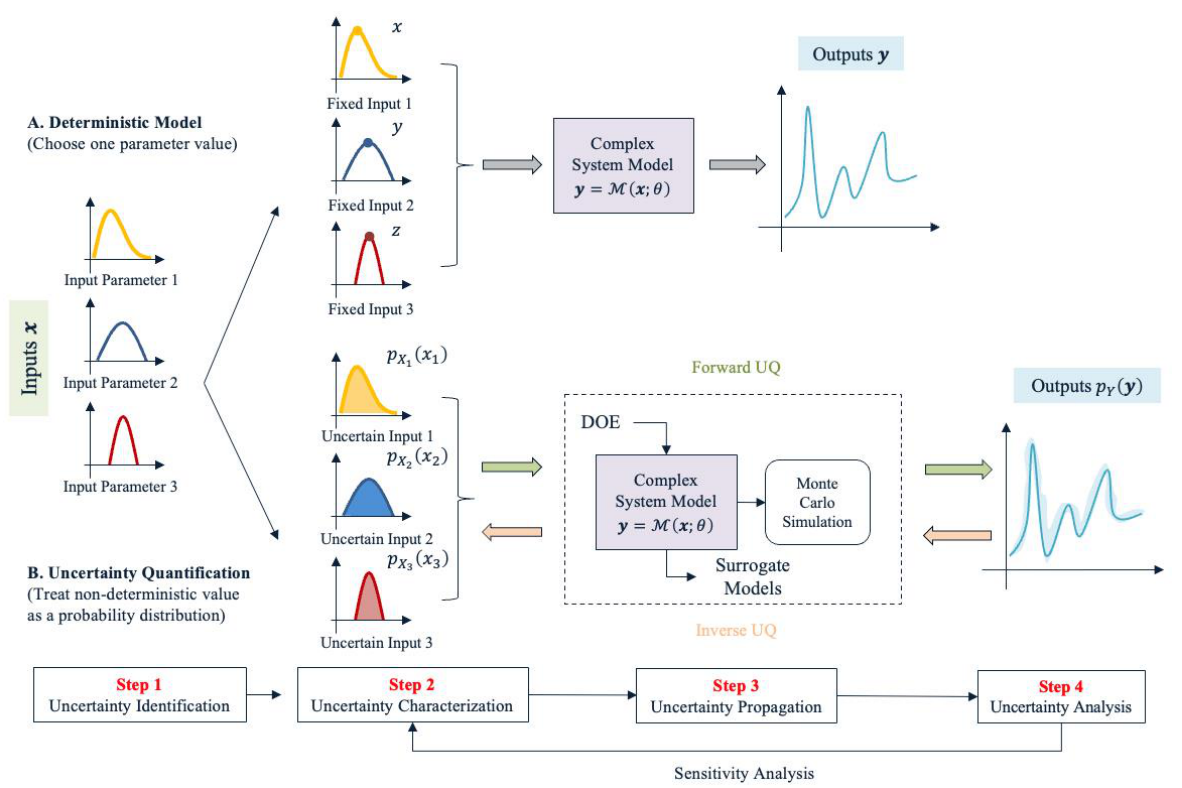
Figure 6. A standard uncertainty quantification